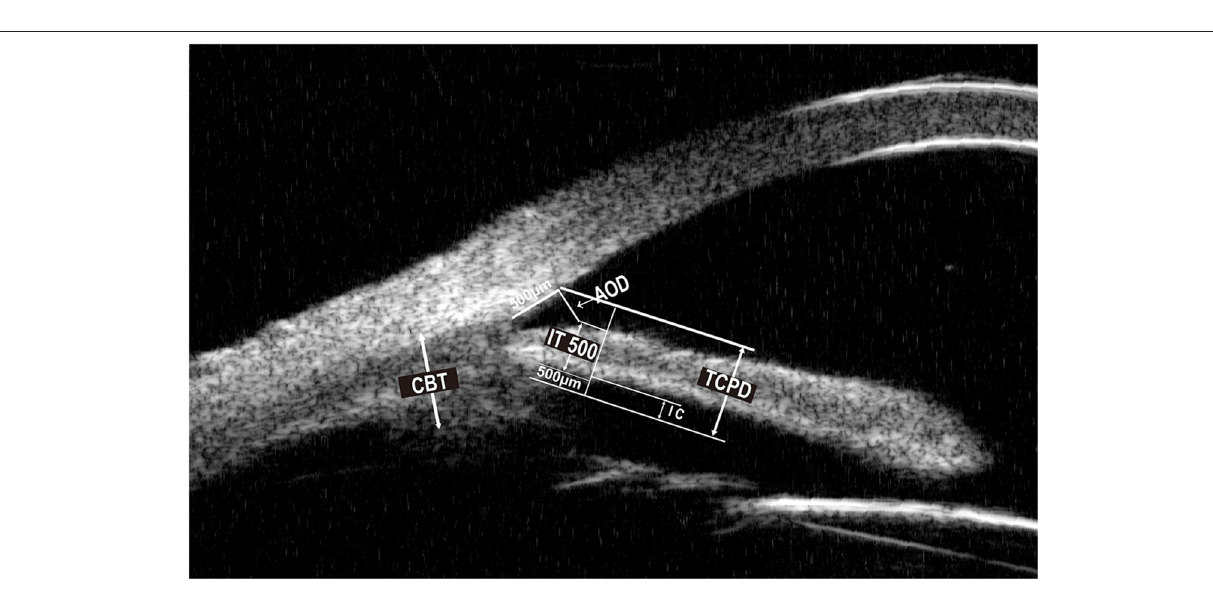
Frontiers in Medicine |